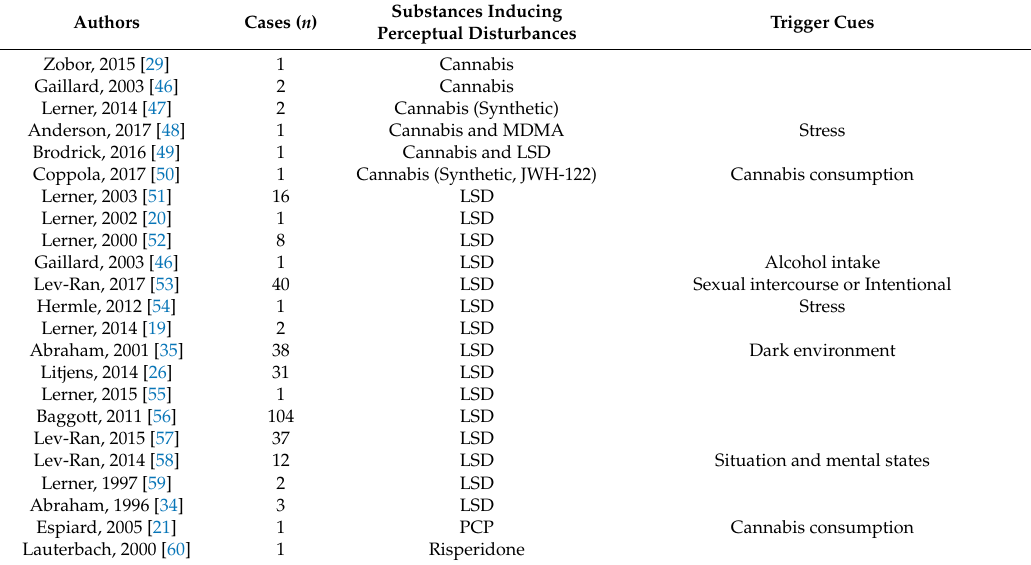
Table 1. Substances that induce Hallucinogen Persisting Perception Disorder